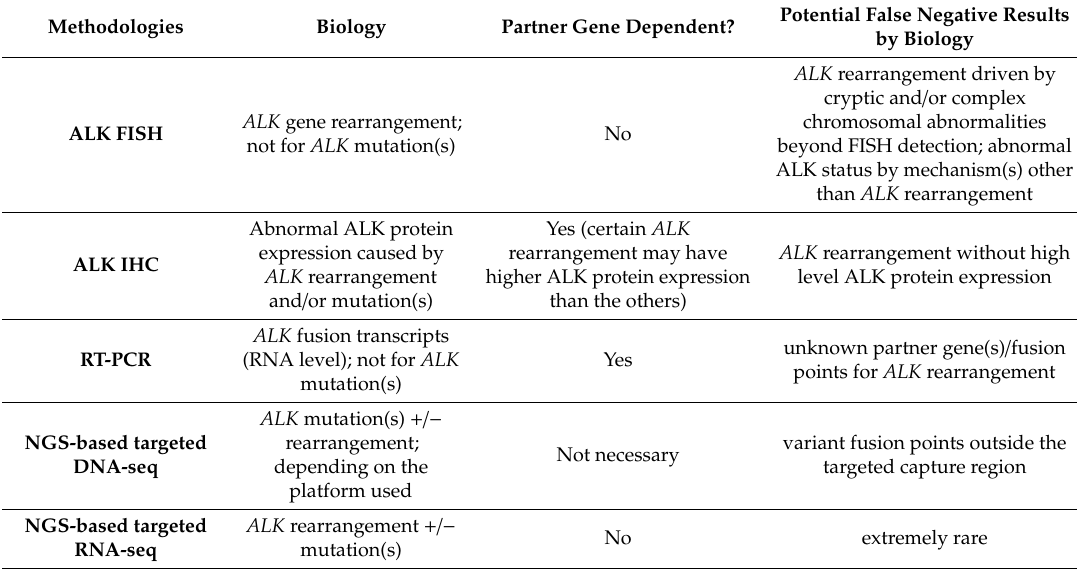
Table 1. A brief comparison of methodologies being applied for evaluation of ALK